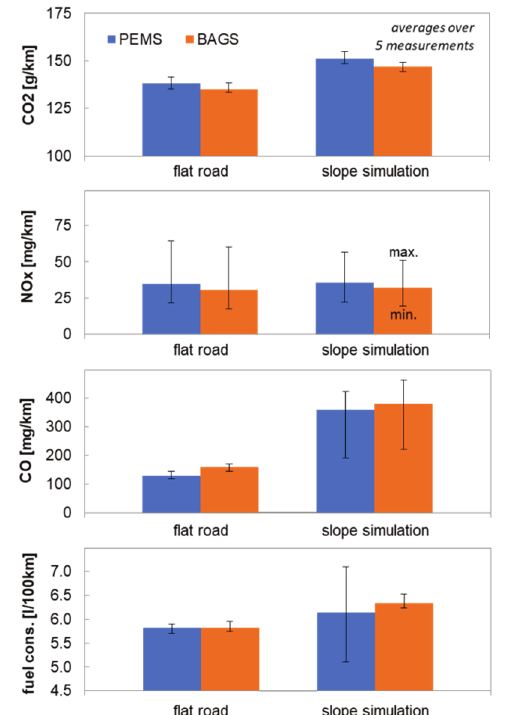
Fig. 15. Influence of real slope simulation on chassis dyno on exhaust emissions; HORIBA OBS One; Volvo (V1)